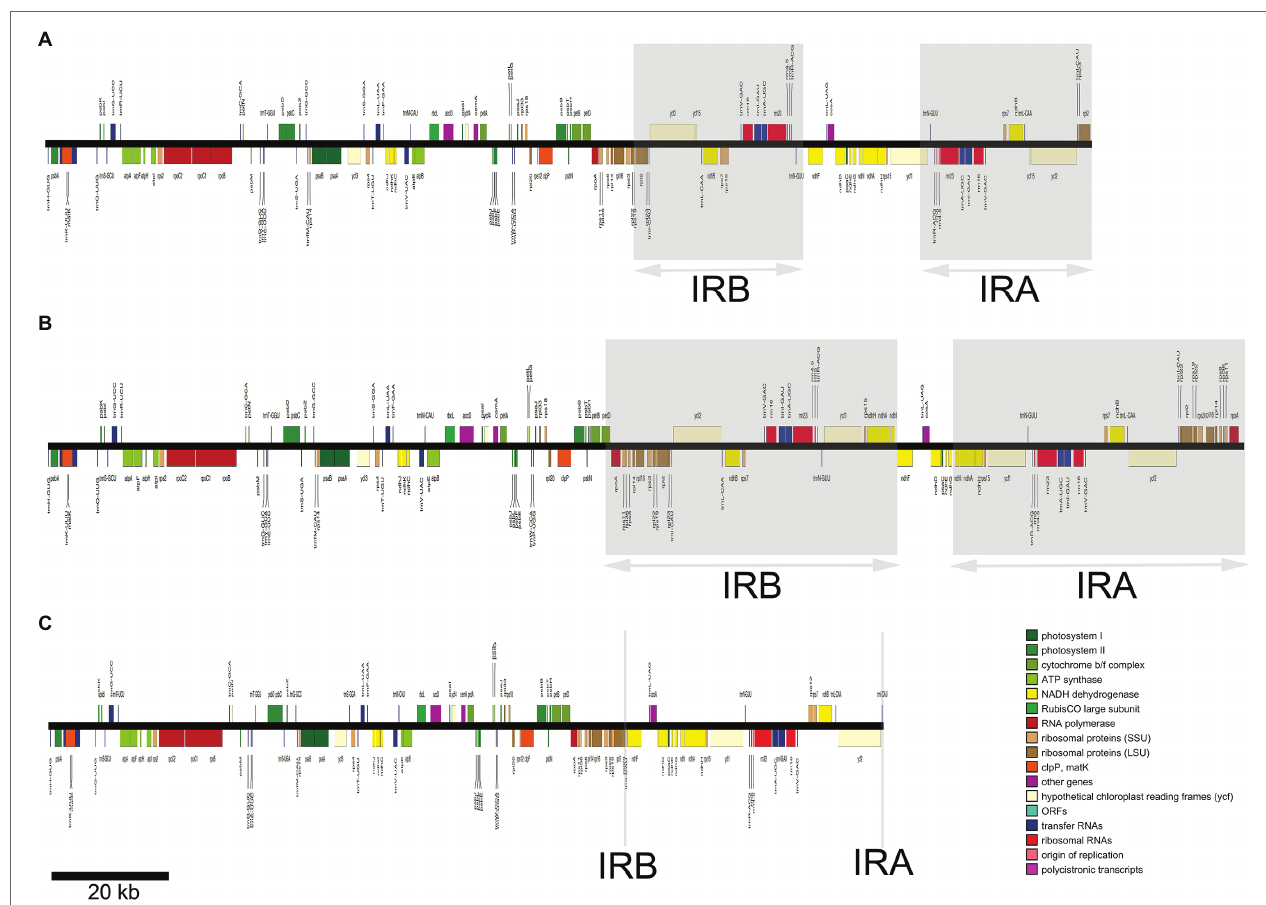
FIGURE 1 | The plastid genomes of three representative Euphorbia species represented in linearized form, illustrating the large-scale expansion and contractions of the inverted repeat (IR) regions. Genes belonging to different functional categories are depicted by colored boxes proportional to the length of genes. Gray areas indicate IR region A and region B (IRA and IRB). Linear maps are drawn to the scale as indicated by the bar at the bottom left. The plastid chromosomes of (A–C) indicate E. esula , Euphorbia schlechtendalii , and Euphorbia neogillettii ,